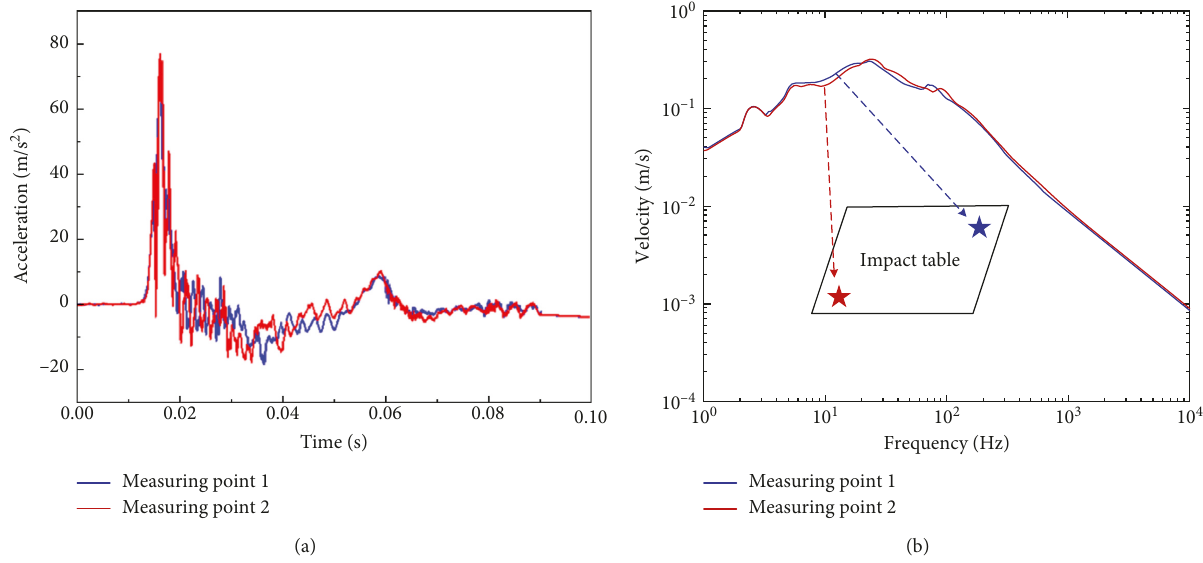
Figure 3: Comparison of measuring points 1 and 2 under working condition 1. (a) Acceleration curves with of measuring points 1 and 2. (b) Shock spectrums of measuring points 1 and